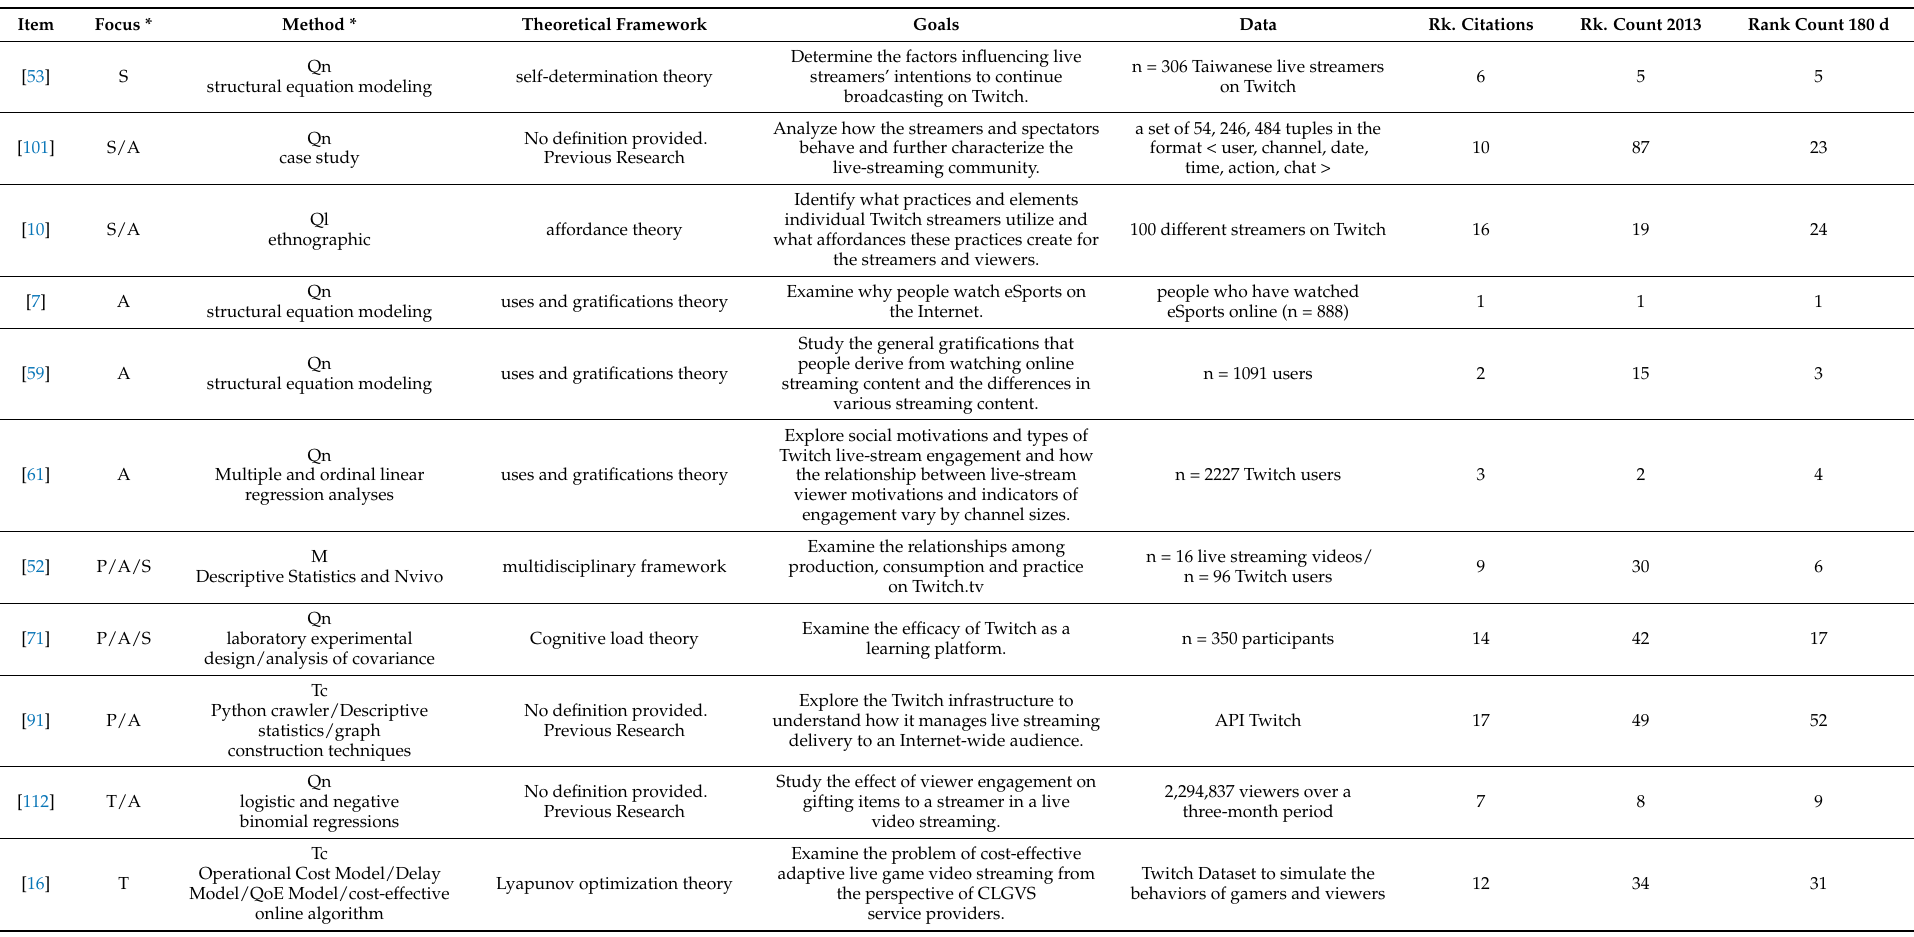
Table A1. Top ranking documents in each of the specializations or subdomains